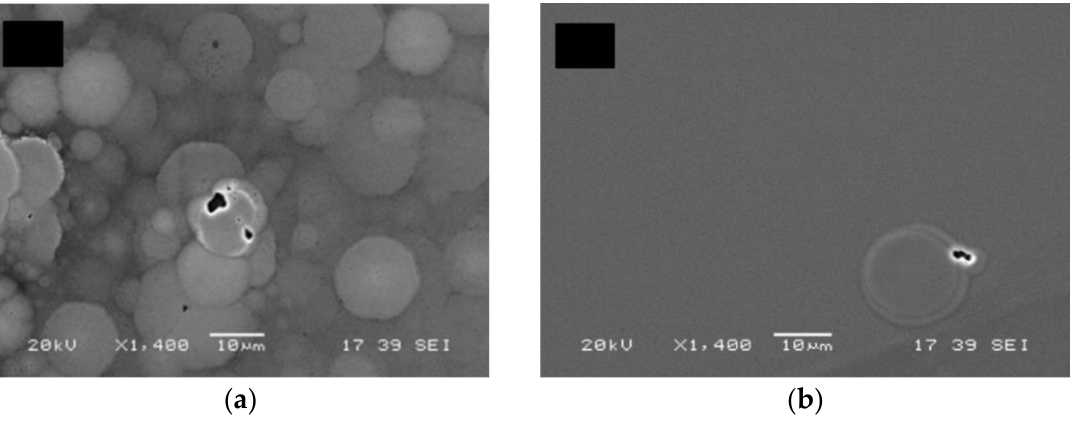
Figure 12. SEM images showing improvement in surface morphology of thicker GaN films. ( a ) 300 nm- and ( b ) 1.1 µm-thick GaN films (republished with permission of IOP Publishing, from “Growth of GaN epitaxial films on polycrystalline diamond by metal-organic vapor phase epitaxy," Q. Jiang, D. W. E. Allsopp, and C. R. Bowen, vol. 50, no. 16, 2017 [136]; permission conveyed through Copyright Clearance Center, Inc.).